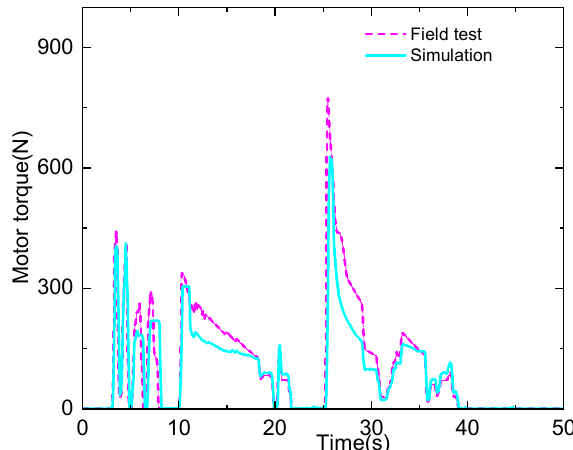
Figure 11. Torque result of driving motor.